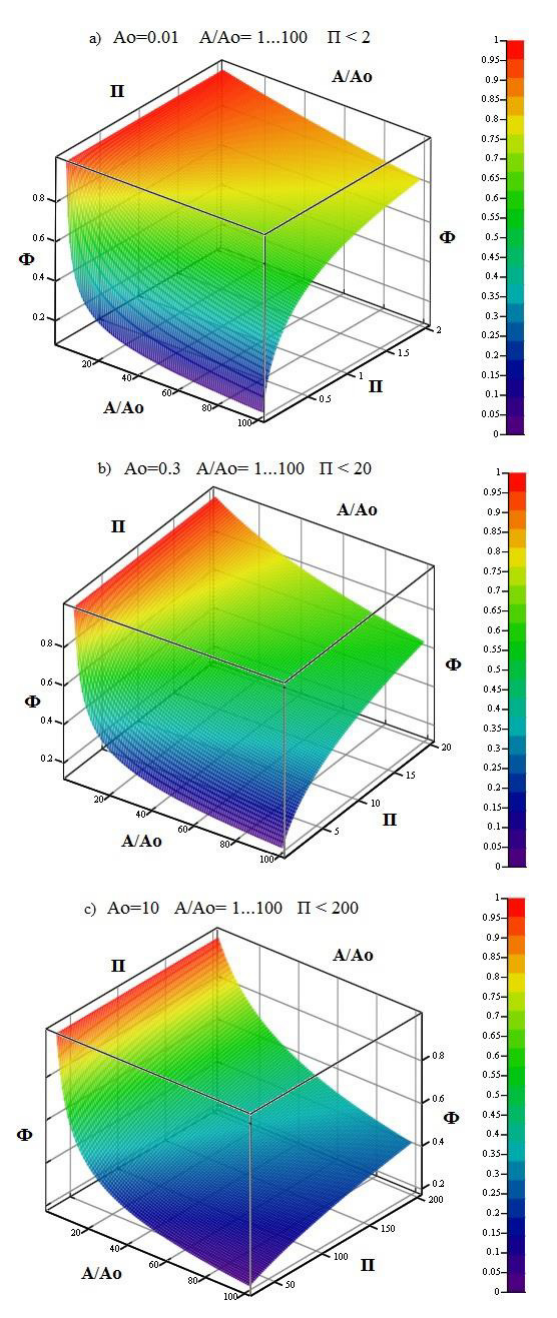
Fig. 2. The degree of SNR reduction as a function , at wide of the background noise intensity A/A 0 variations of the normalized echo signal: П = 10 -2 … 2∙10 2 , and the photodetector’s excess noise: А = 10 -2 (a), А = 0.3 (b), А = 10 (c). 0 0 0 The generalized parameters L and L , which 0A 0B predict the potentialities of lidars at sounding the reference medium, are determined at Π=1.